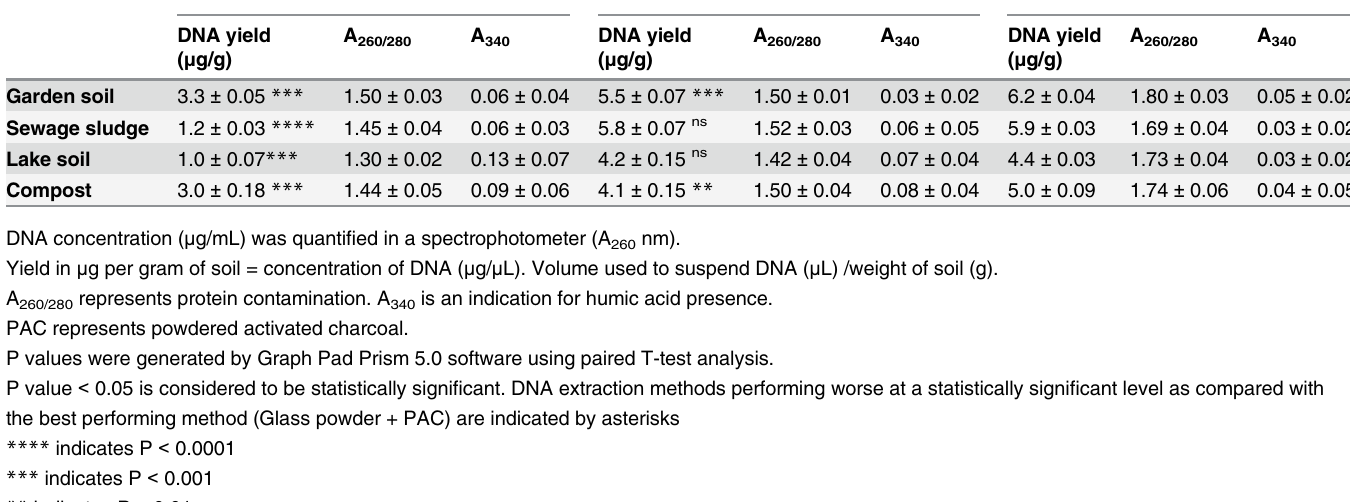
Table 5. Assessment of yield and purity of the DNA extracted by method M2 and its modification (glass beads, glass powder and glass powder + powdered activated charcoal).